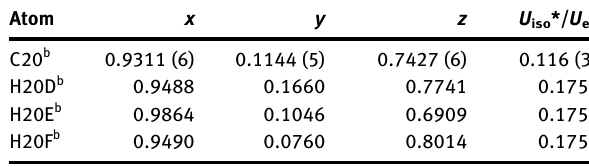
Table  : Fractional atomic coordinates and isotropic or equivalent isotropic displacement parameters (Å 